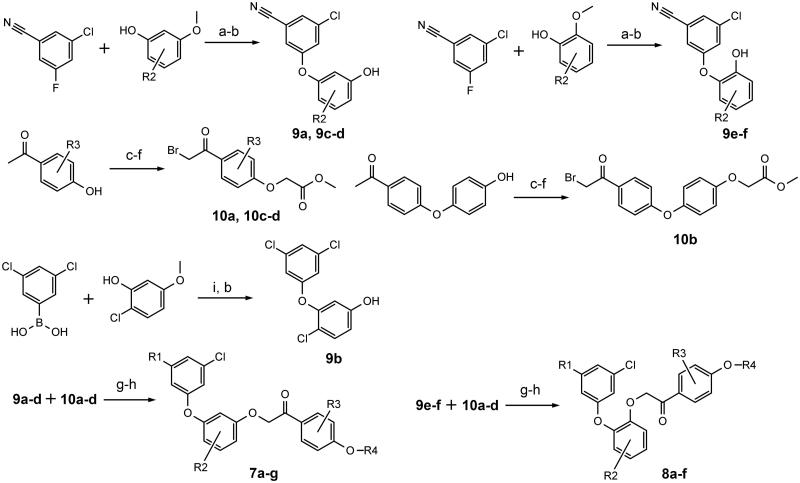
Synthesis scheme (a) K2CO3, N-methylpyrrolidone, 120 °C, 4 h (b) BBr3, CH2Cl2, 0–25 °C, 5 days (c) ethyl chloroacetate, K2CO3, KI, acetone, reflux, 4 h (d) NaOH, CH2Cl2 – CH3OH (9:1), 25 °C 1 h, then diluted HCl (e) CH3OH, p-toluenesulfonic acid, reflux, 4 h (f) N-bromosuccinimide, p-toluenesulfonic acid, CHCl3, 25 °C, 12 h (g) K2CO3, acetone, 25 °C, 4 h (h) K2CO3, CH2Cl2 – CH3OH – H2O, 25 °C, 1–2 days (i) Cu(CH3COO)2, pyridine, CH2Cl2, 25 °C, 2–3 days. R1-R4 groups are as in Table 1.